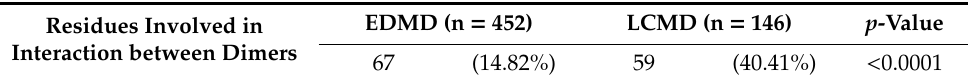
Table 3. Type of mutations among Emery–Dreifuss (EDMD) and LMNA -related congenital muscular dystrophies (L-CMD) index